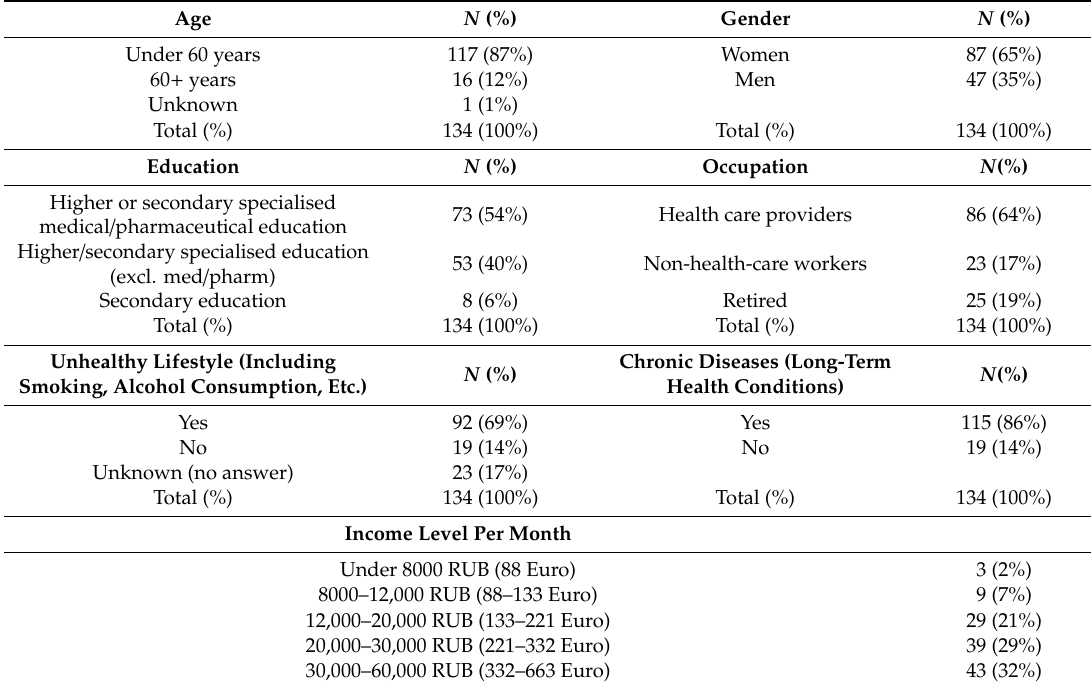
Table 1. General characteristics of the survey